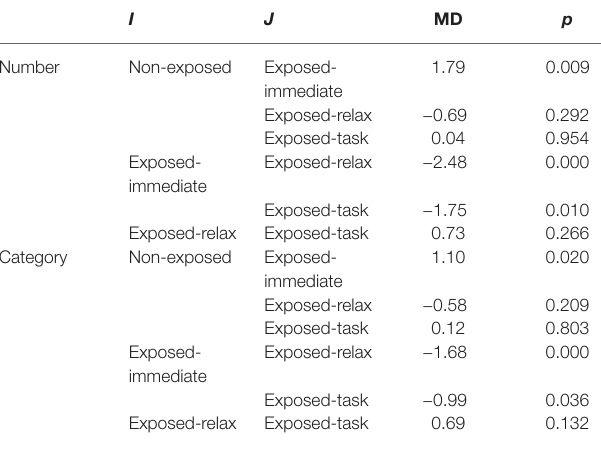
TABLE 2 | Post hoc multiple comparisons of ideas generated in last 10 min (Experiment